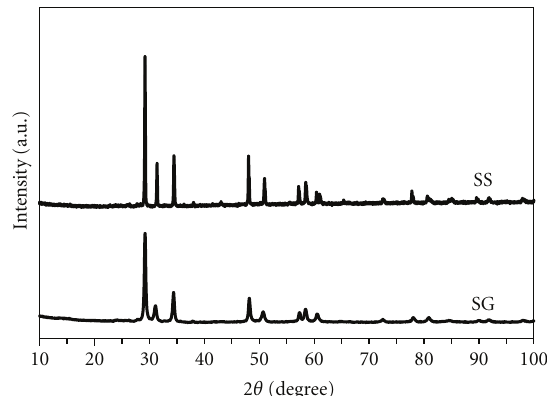
Figure 1: X-ray di ff raction patterns of Sm 2 FeTaO 7 synthesized by solid state reaction at 1400 ◦ C during 36 hours and by sol gel at 800 ◦ C during 6 hours